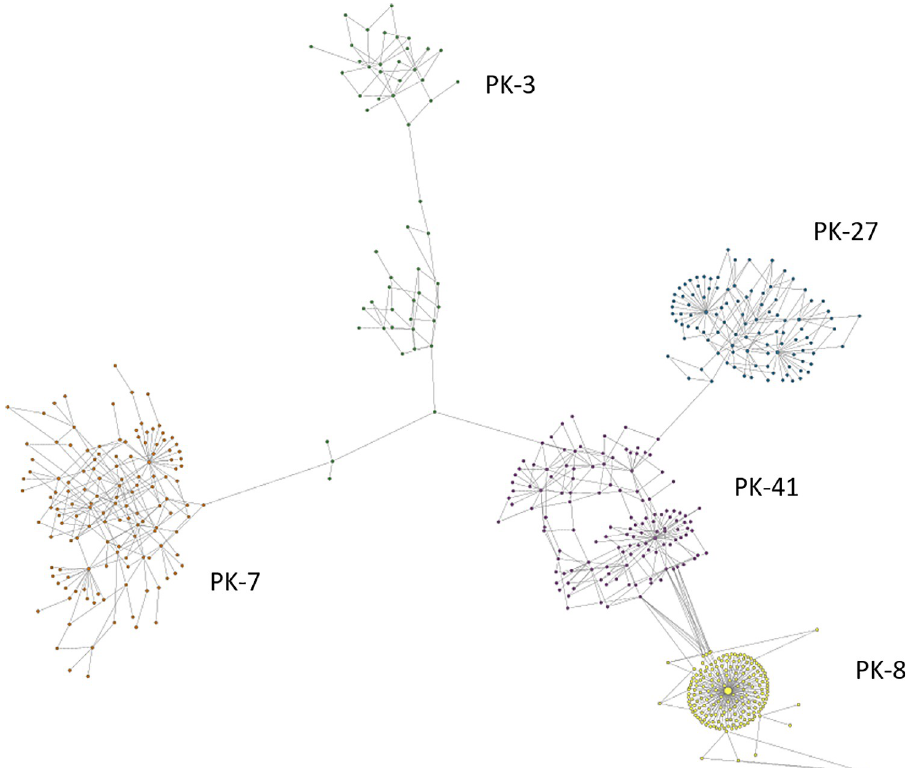
Fig 3. K-step network of the transmission cluster. Color identifies haplotypes from each case. Only genotype 3a haplotypes from PK-3 are shown.